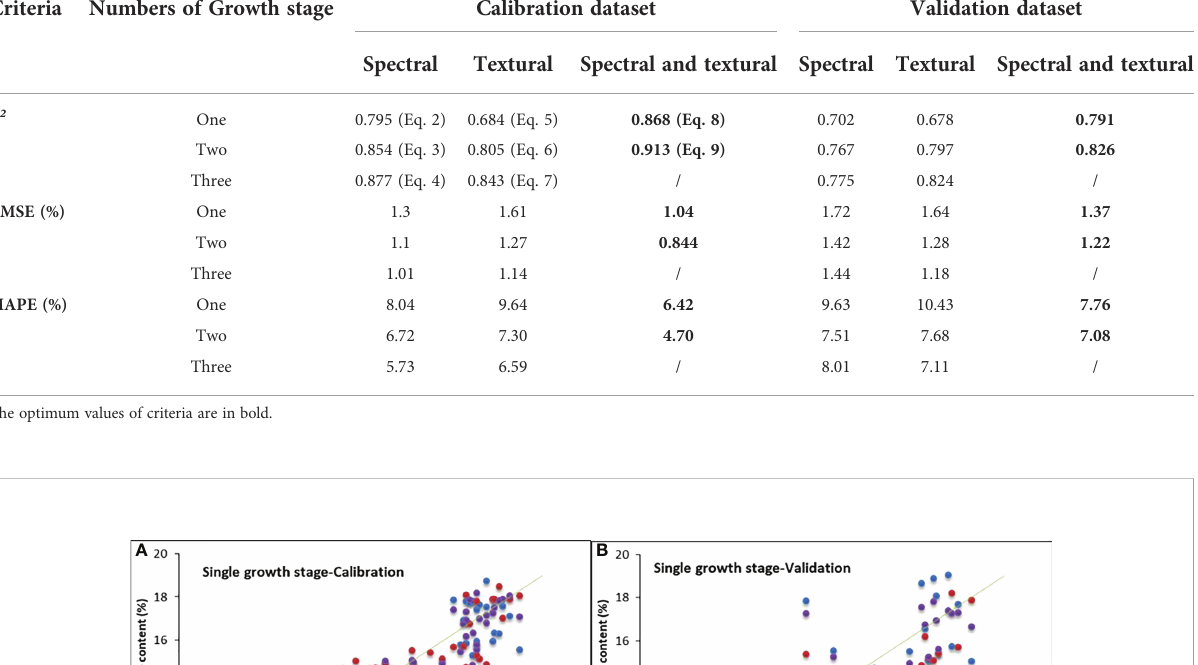
TABLE 8 Model test results by the calibration and validation datasets.